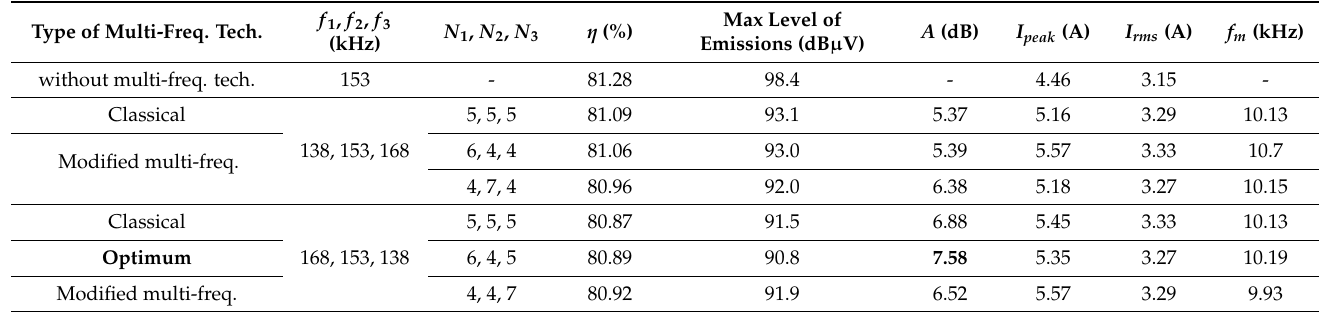
Table 5. The performance characteristics of the wireless battery charger without the multi-switching- frequency technique and with the technique (with different combinations of a number of pulses and the order of the switching frequencies). The load resistance is 12.6 Ω , and the lateral misalignment is 1 cm. Type of Multi-Freq.